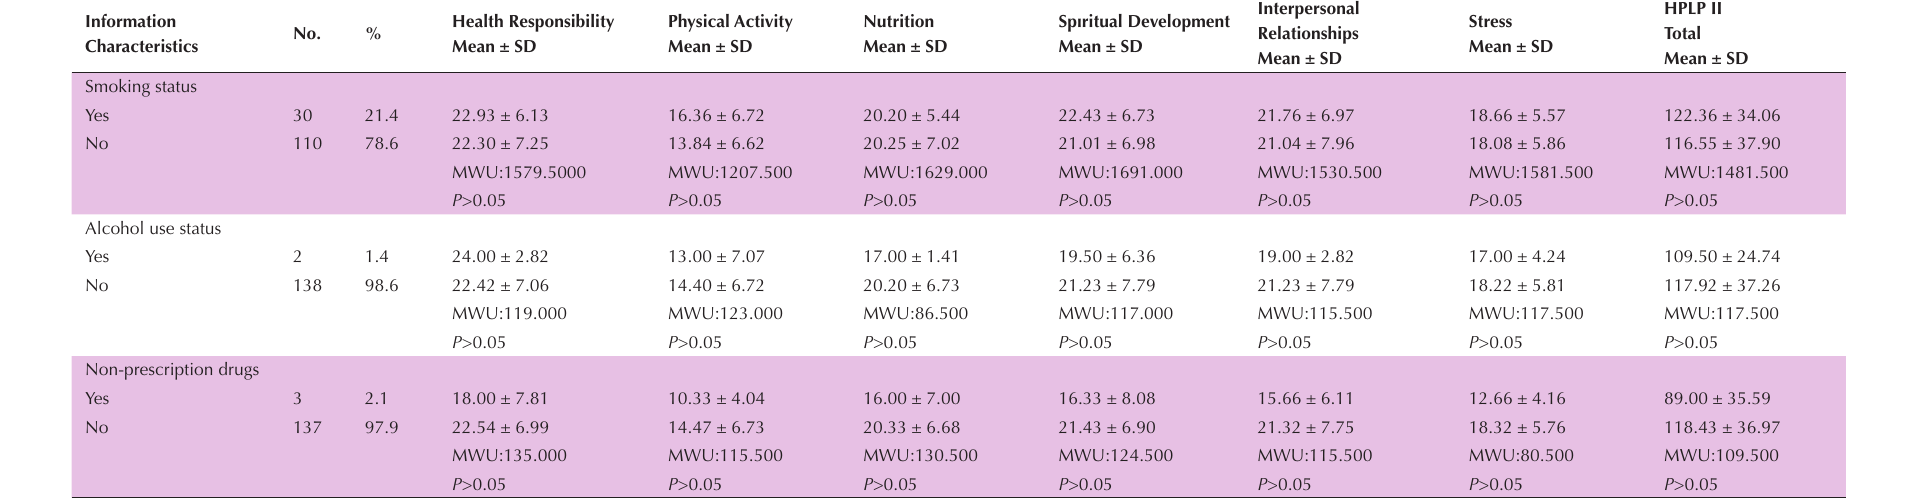
Table 4. The Distribution of patients’ average score from the HPLP II according to cigarette, alcohol and non-prescription drug use situations Information Characteristics